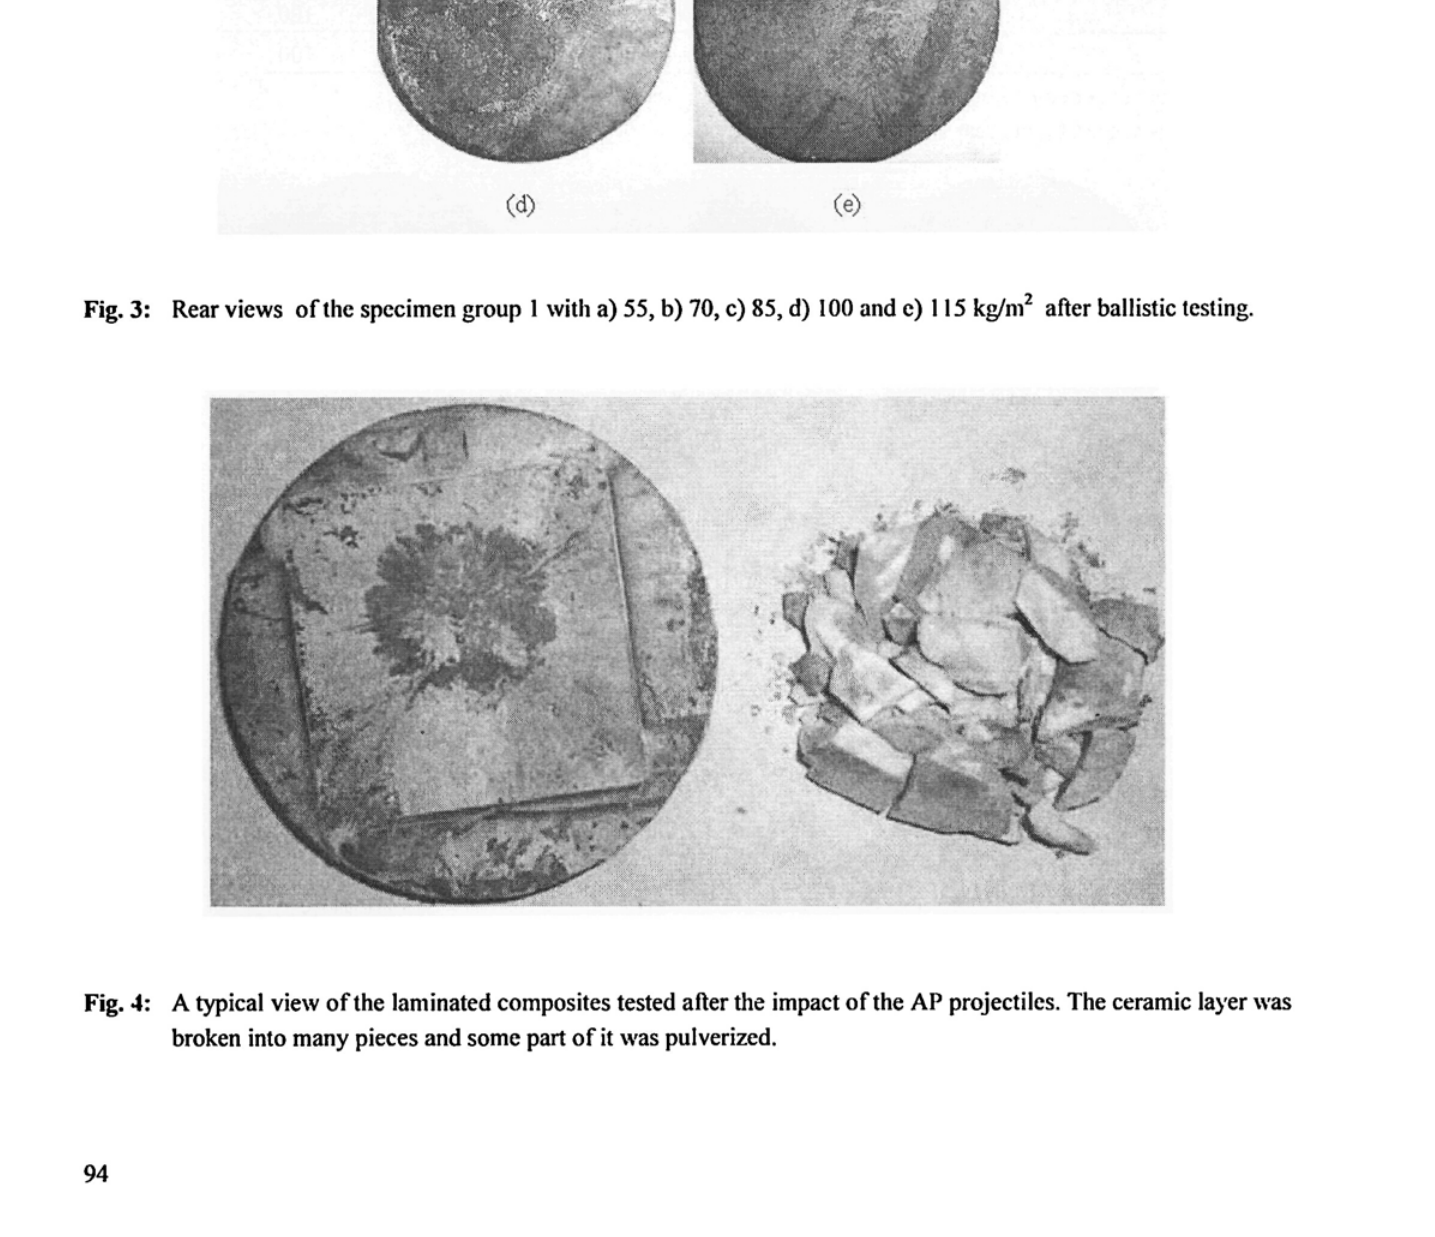
Fig. 4: A typical view of the laminated composites tested after the impact of the AP projectiles. The ceramic layer was broken into many pieces and some part of it was